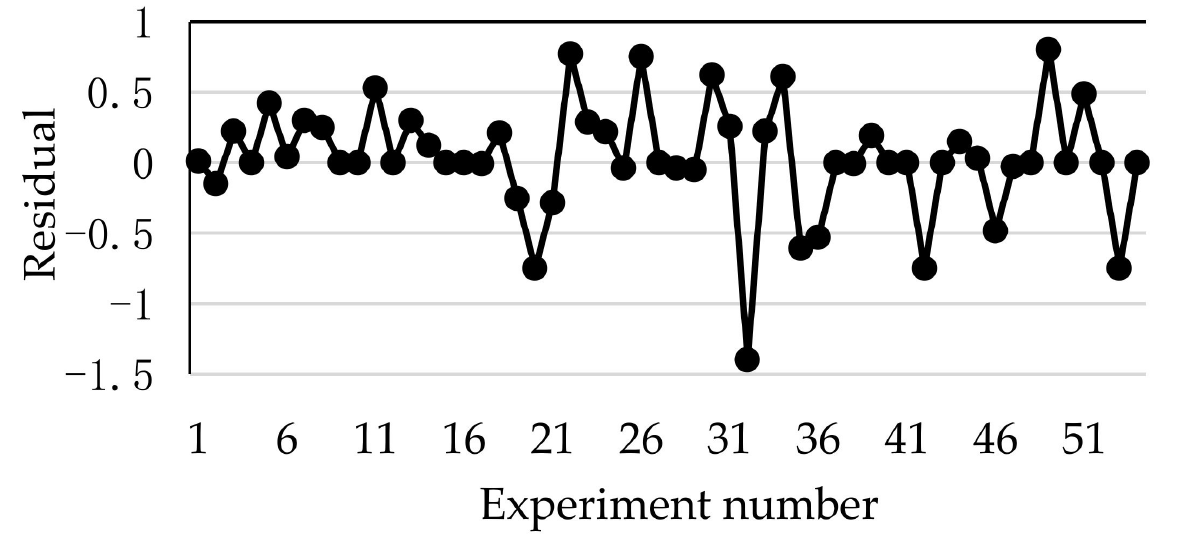
Figure 5. The error estimated to predict the response during ANN